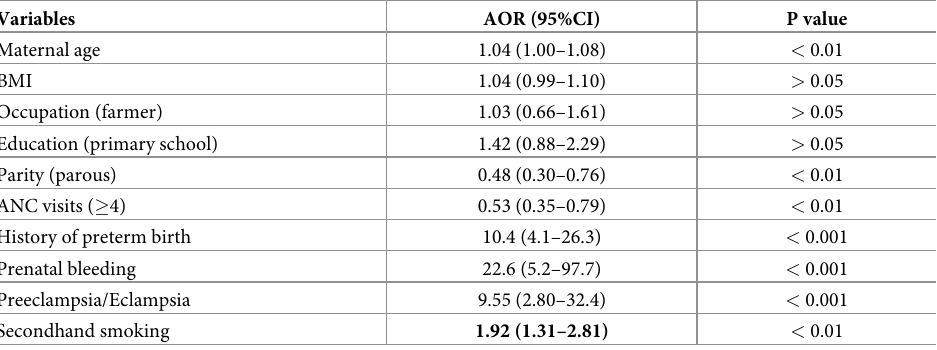
Table 2. Association between secondhand smoking and preterm birth before 37 weeks in multivariable logistic regression analysis.